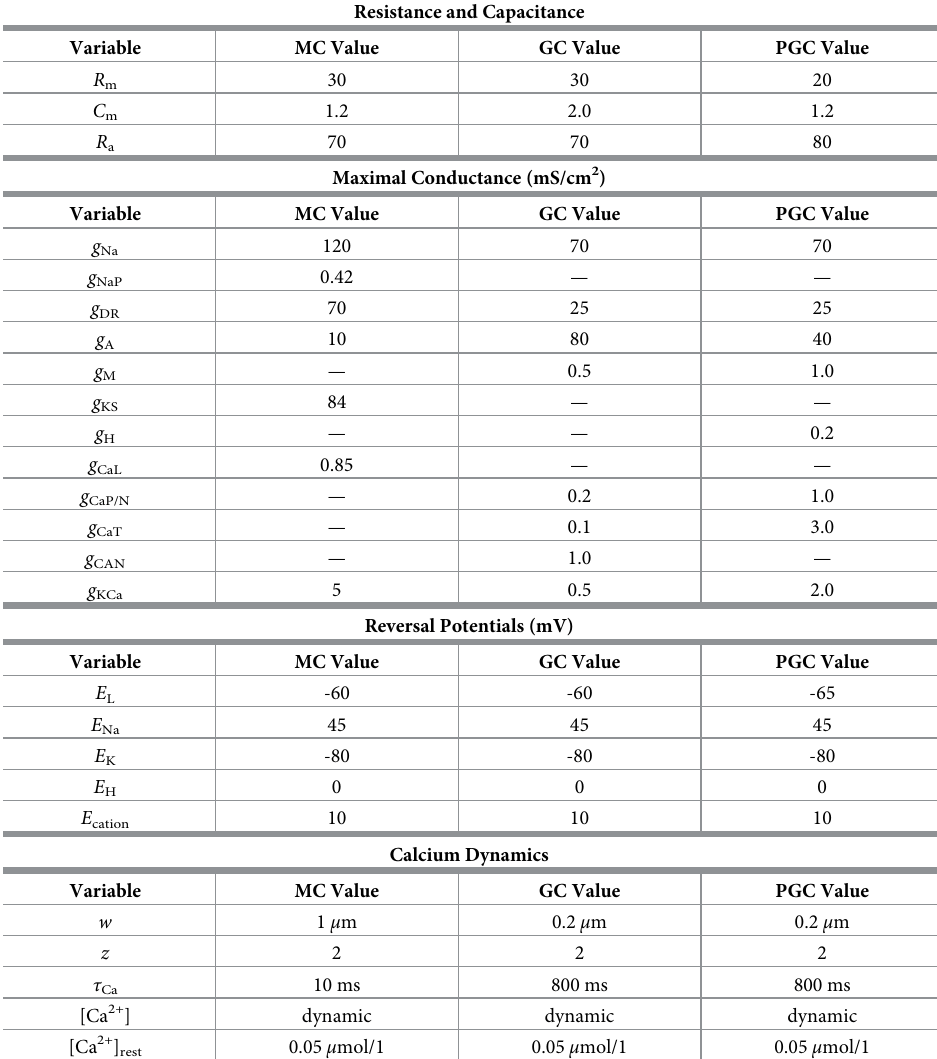
Table 4. Parameter values for each cell type. Each of these values are the same as defined by [30] with the exception of maximal conductance values which are the sum of all cell compartments (soma, dendrite, axon, etc.) as defined by [30]. Additionally, any conductance value denoted by − implies that this ionic current is not included in the associated